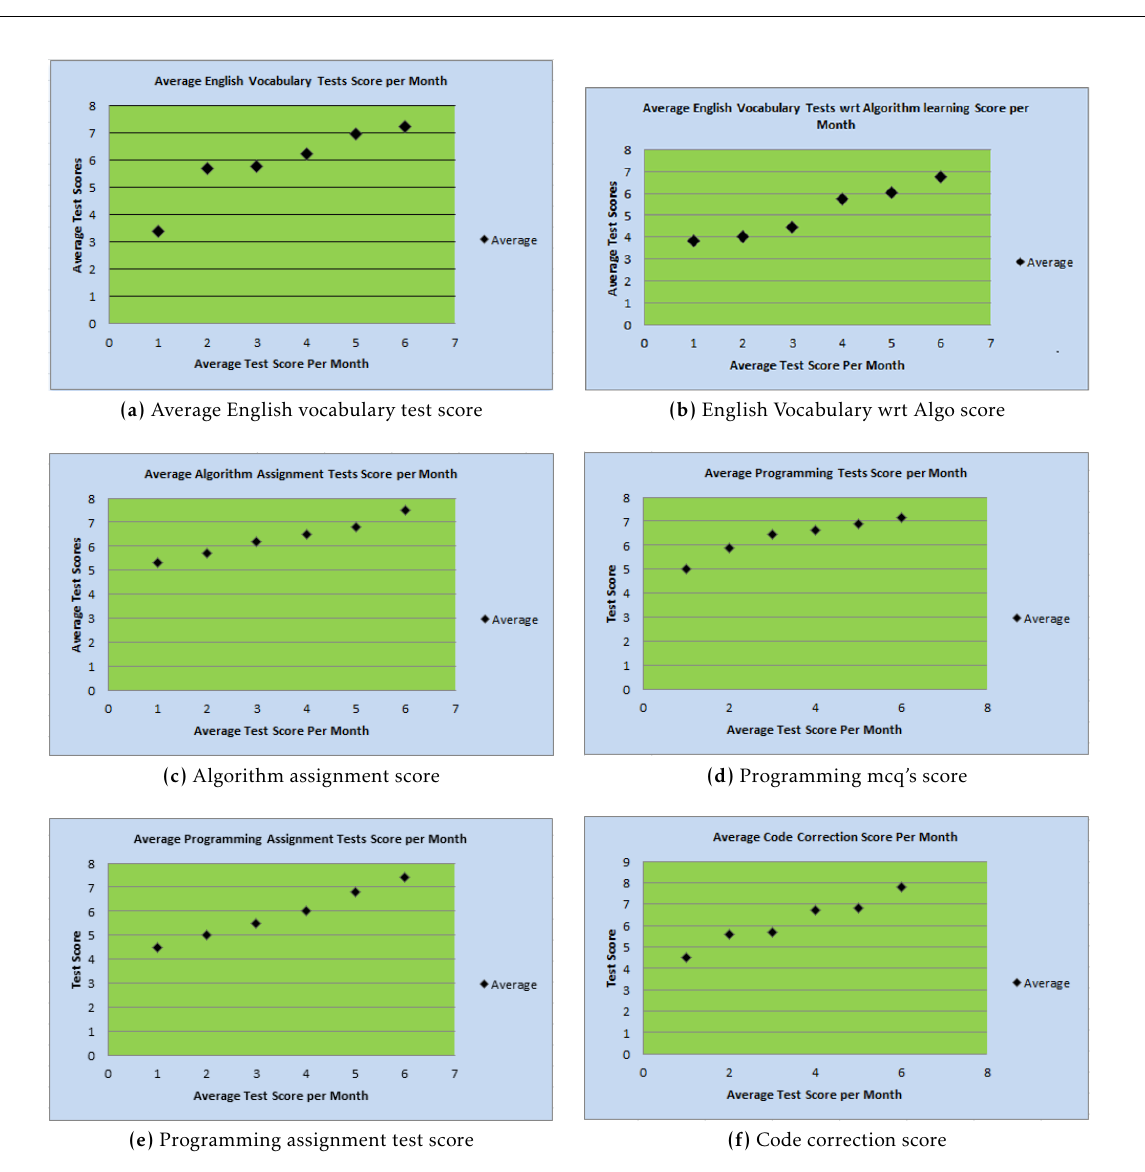
Figure 3. Students’ scores in IEPLS